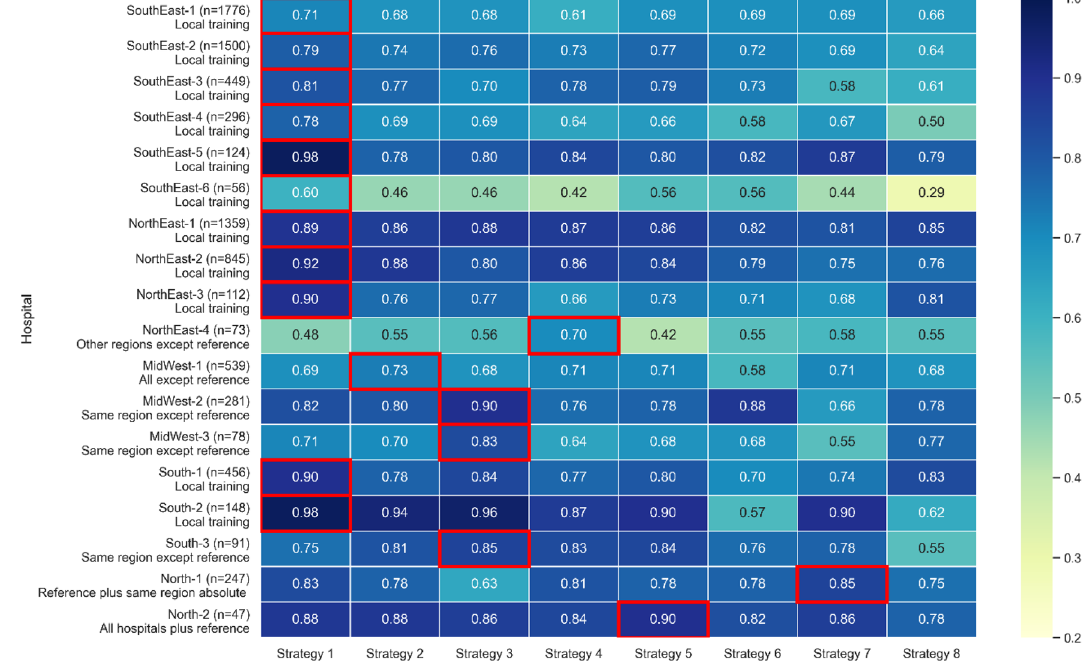
Figure 1. Best AUROCs according to strategy, region and hospital with the best strategy